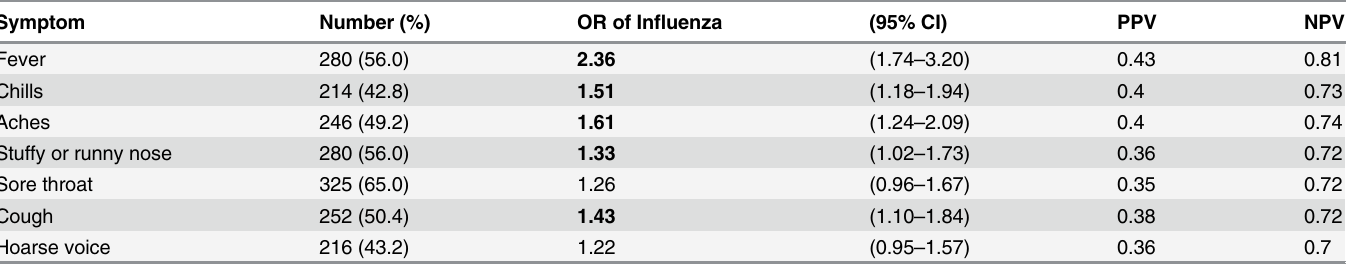
Table 3. Symptom distribution in subjects and prevalence rate ratios with predictive